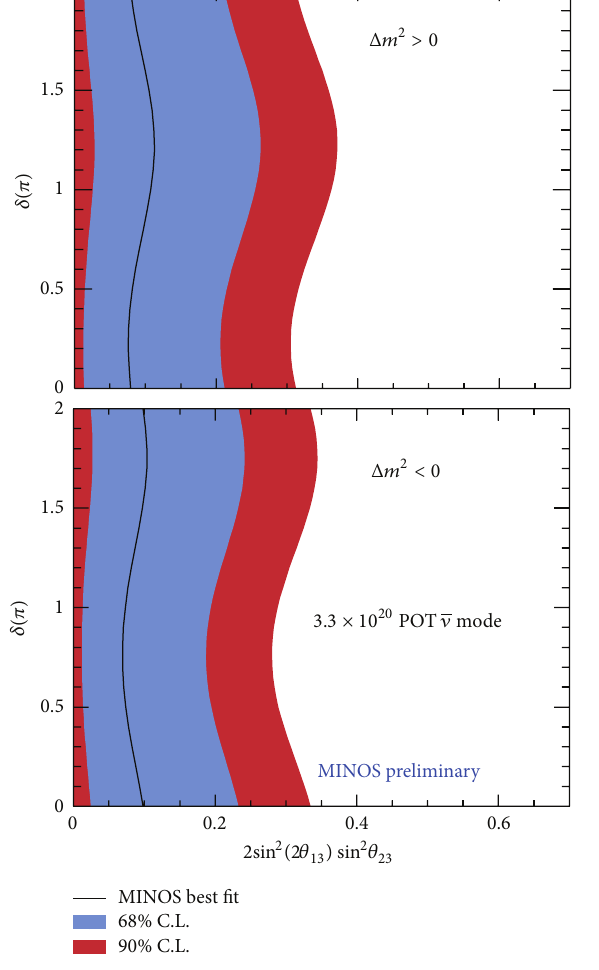
Figure 19: MINOS allowed regions for antineutrinos as a function of the CP violating phase and 2 sin 2 (2𝜃 13 ) sin 2 𝜃 23 . See Figure 18 for the full description. These results were preliminary at the time of writing